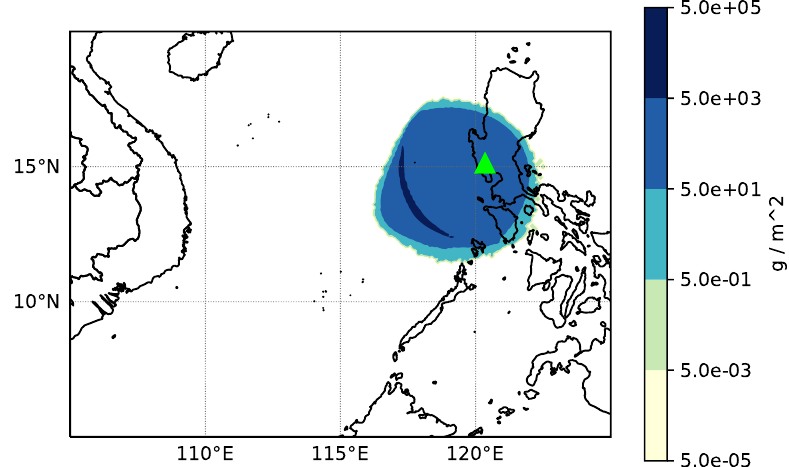
Figure A1. Modelled ash column loads within the Pinatubo ash cloud at 09:40 UTC on 15 June 1991 showing issues with particle accumulation on the leading edge of the theoretical umbrella cloud radius predicted by Equation (4). The volcano location is marked by a green